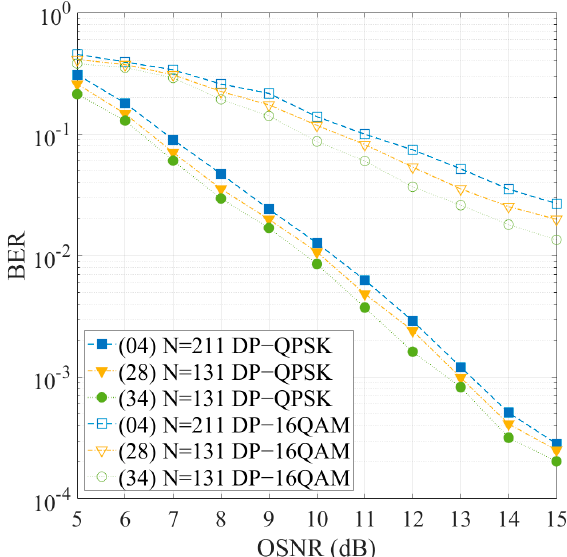
Figure 4. The BER performance of DP - QPSK and DP-16 QAM data with [ 3 / 8,3 / 8] π π Ω ∈ − , the filter (4) has 211 taps, while filter (28) and (34) have 131 taps.